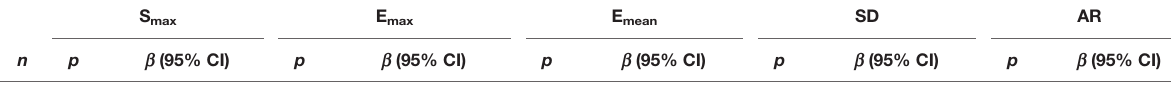
TABLE 2 | Univariate analysis of correlation of histological grading with B-mode ultrasound and shear wave elastography parameters. Variable